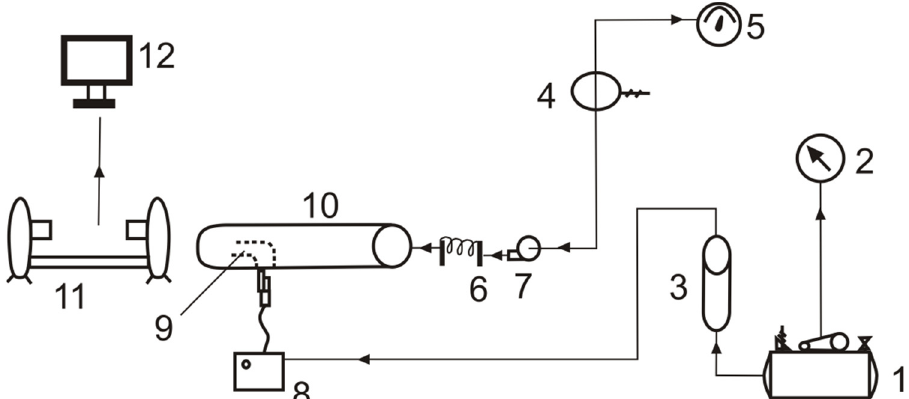
Figure 2. Experimental set-up: 1—compressor, 2—manometer, 3—rotameter, 4—autotransformer,